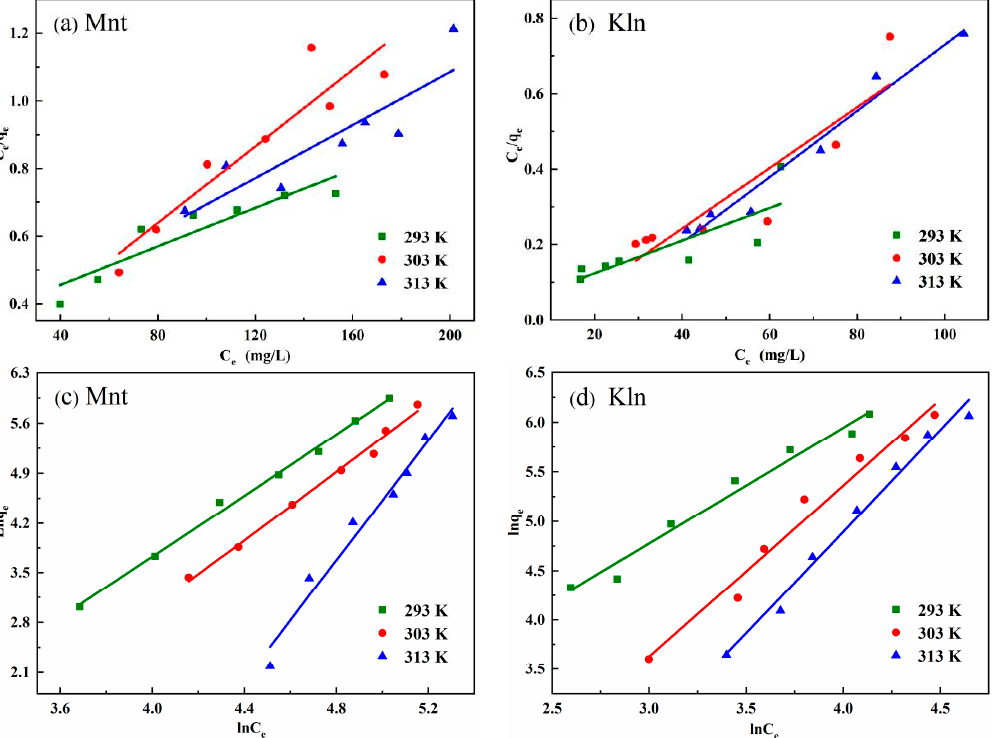
Figure 4. The Langmuir model fitting curves of ( a ) Mnt and ( b ) Kln, and the Freundlich curves of ( c ) Mnt and ( d ) Kln with clay dosage of 0.05 g · L − 1 at 293, 303, and 313 model fitting curves of ( c ) Mnt and ( d ) Kln with clay dosage of 0.05 g·L − 1 at 293, 303, and 313 K. Table 1. Isothermal model of saturates adsorption on clay surfaces derived from Langmuir and Freundlich model.